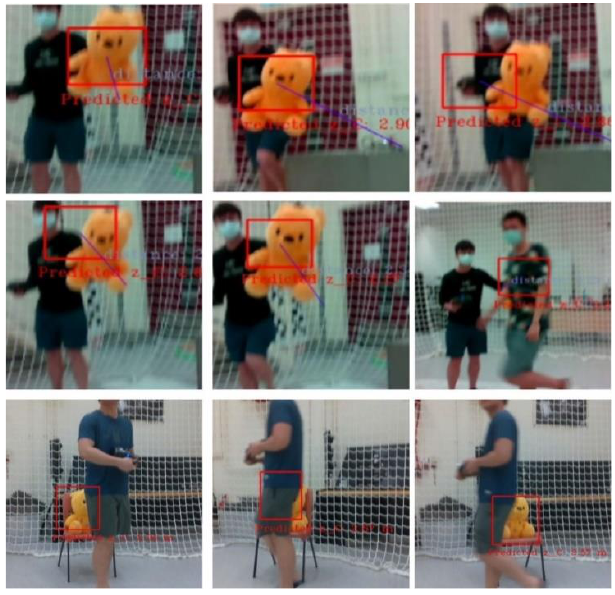
Figure 9. Frames where the target object is not detected or fully/partially occluded.